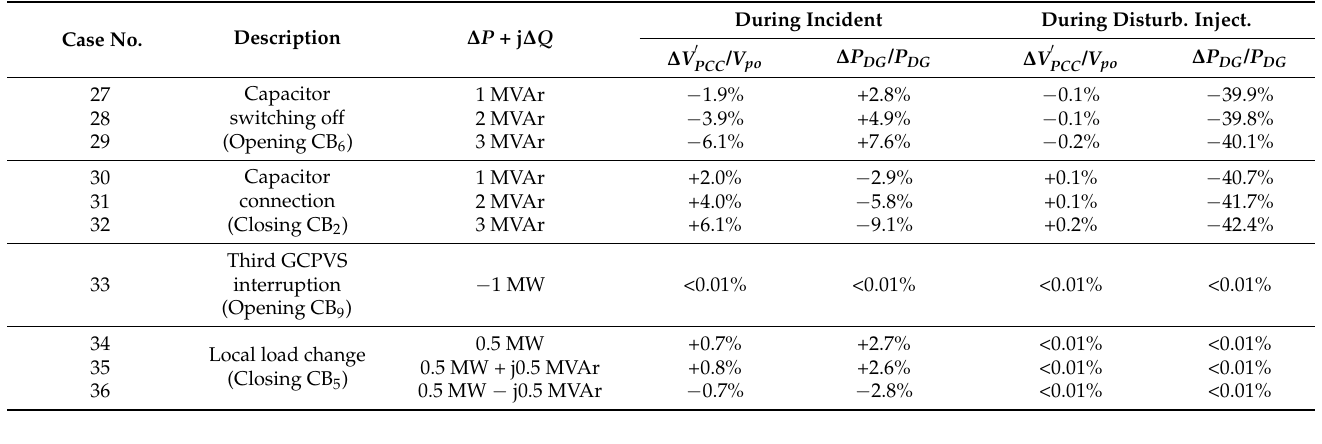
Table 3. Results of the non-islanding scenarios.